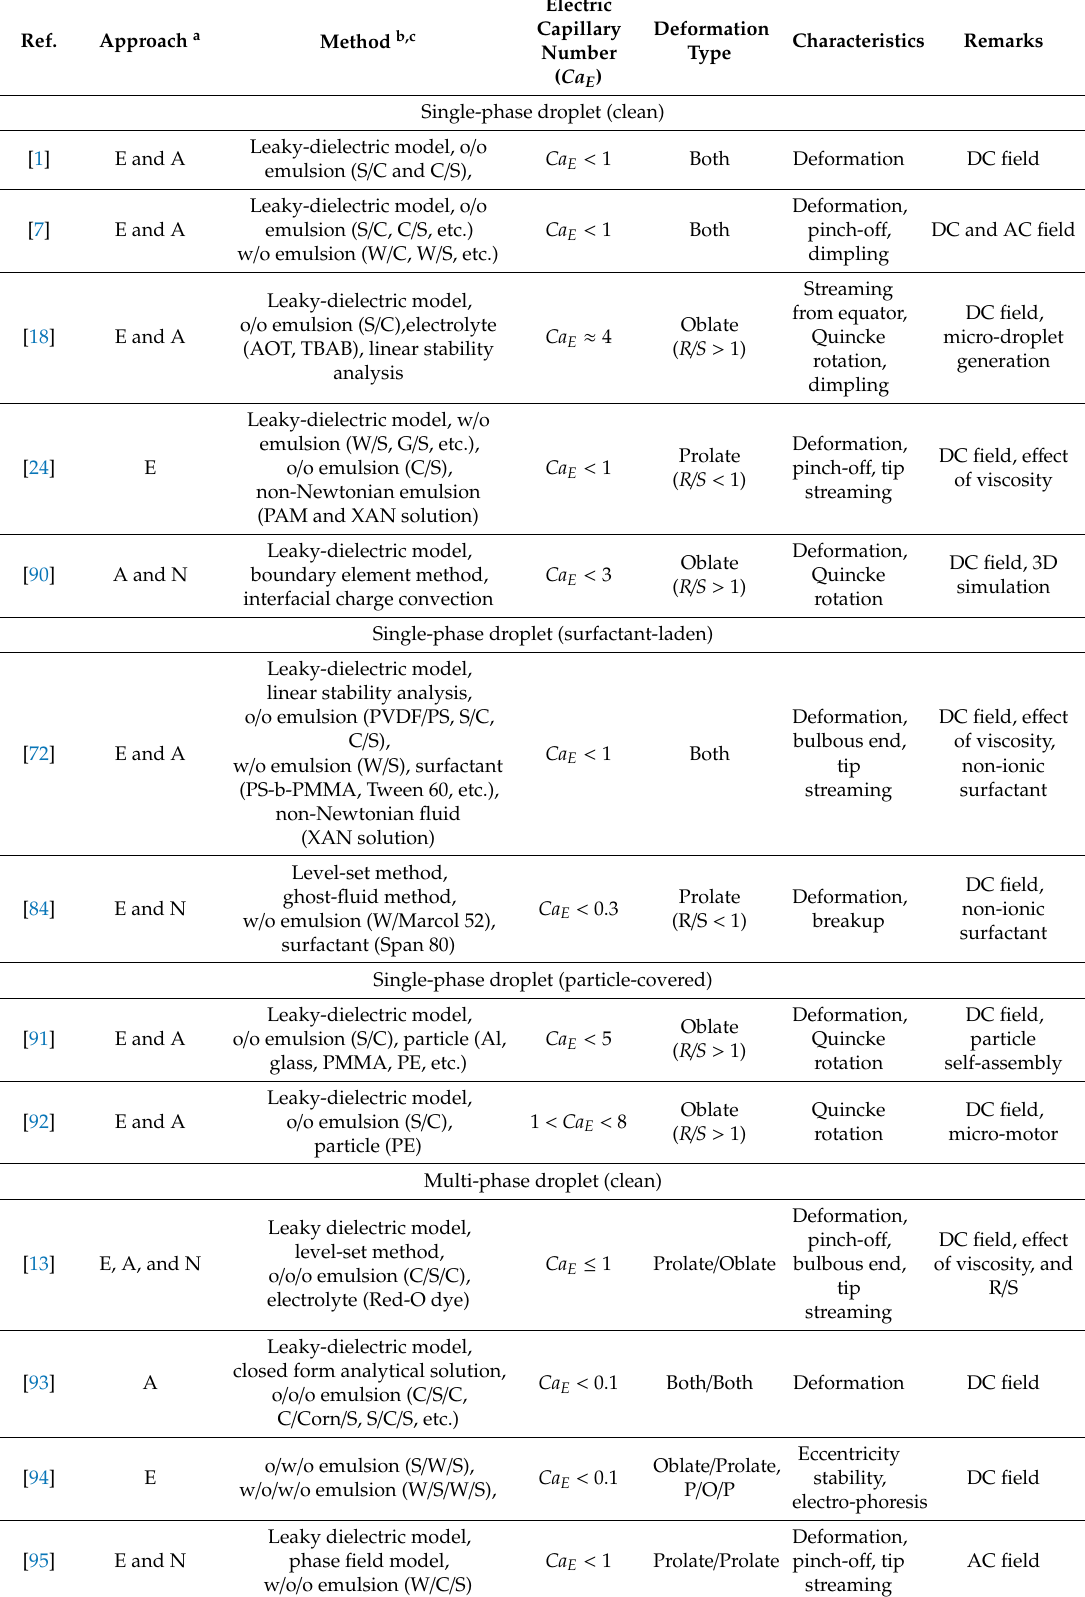
Table 1. Summary of the most prominent works related to droplet electrohydrodynamics.